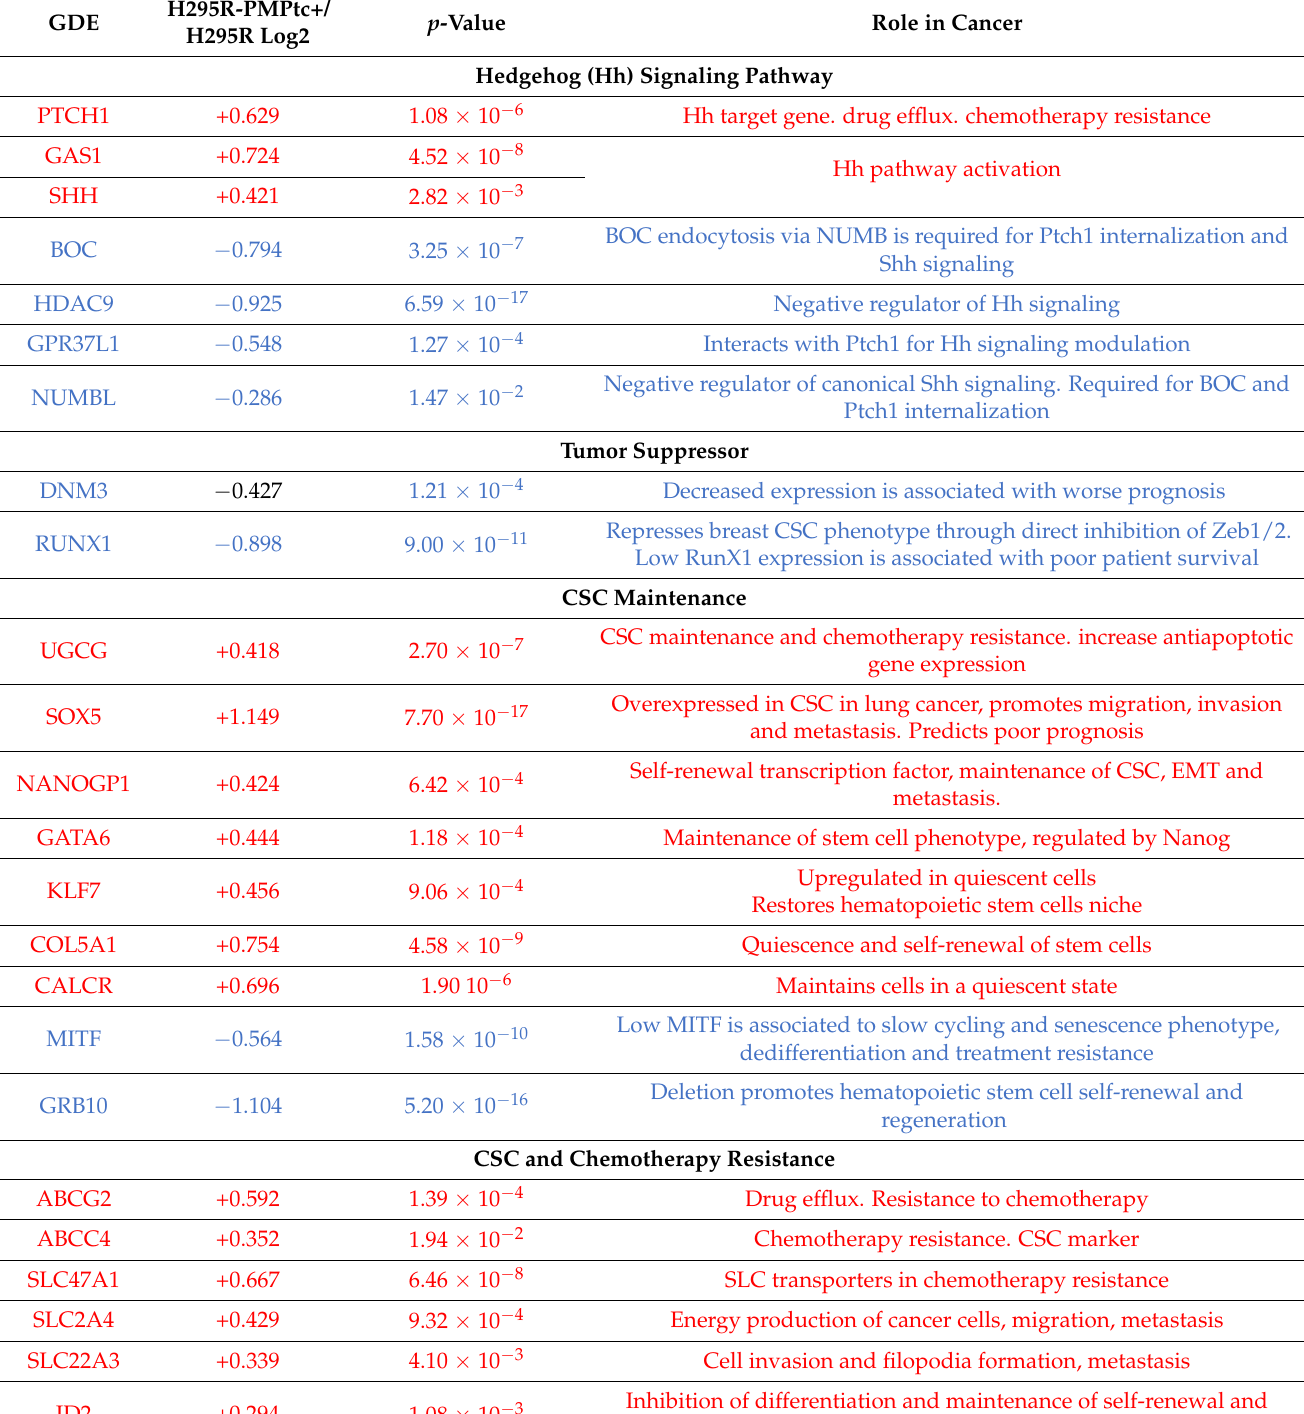
Table 1. Differentially expressed genes (DEG) between H295R-PM-Ptc+ and parental H295R cells selected for their role in cancer. Genes overexpressed are indicated in red and genes underexpressed are in